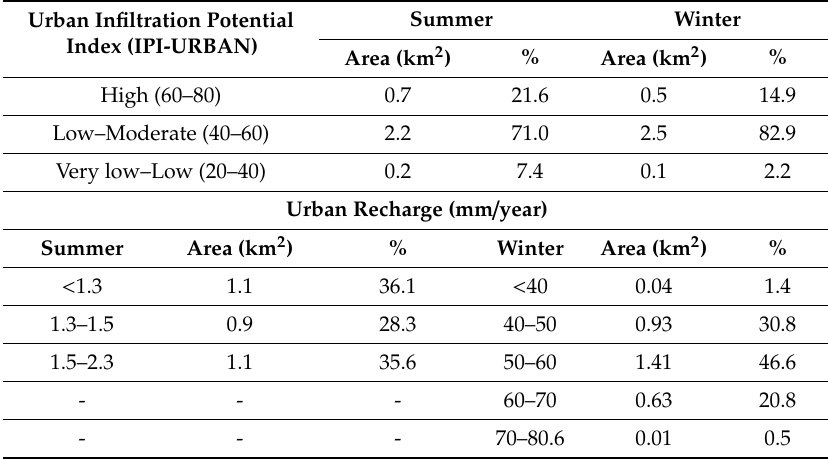
Table 3. Urban Potential Infiltration Index (IPI-Urban) and urban recharge (mm / year): statistical overview.